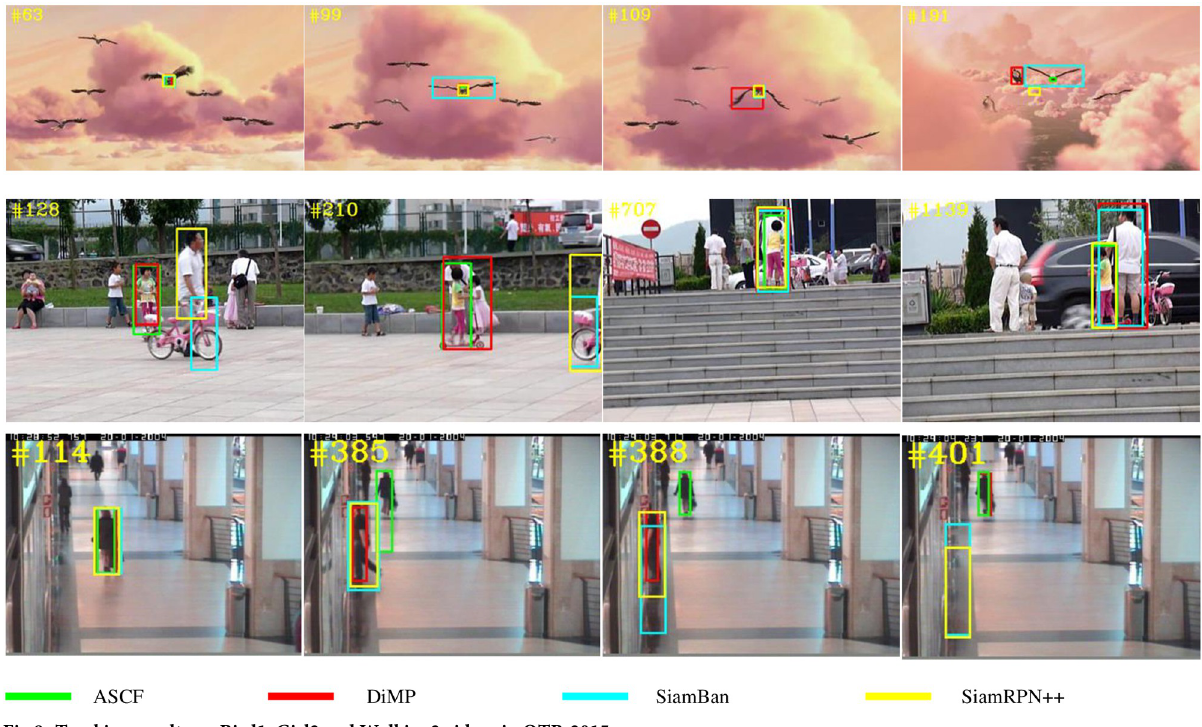
Fig 8. Tracking results on Bird1, Girl2 and Walking2 videos in OTB-2015.